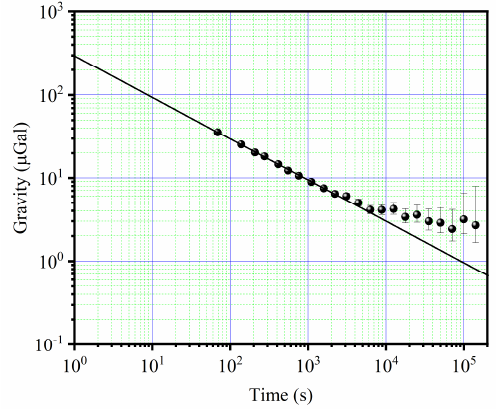
Figure 3. The Allan deviation of the measured gravity data.